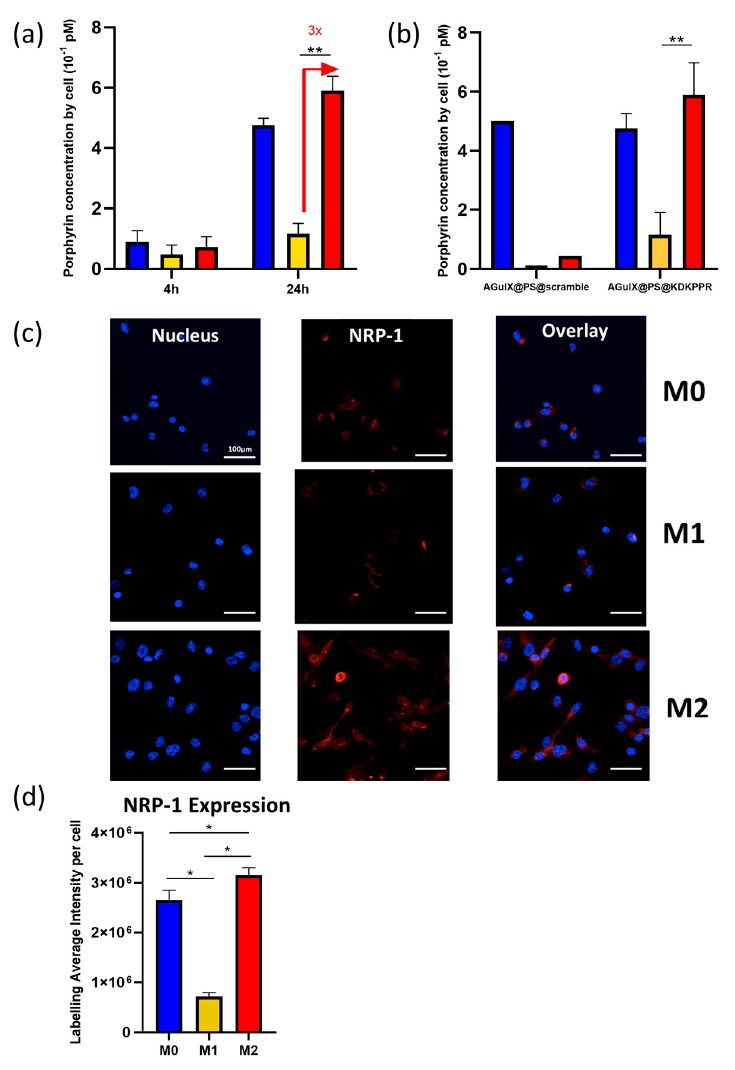
Figure 5. Nanoparticles uptake regarding NRP-1 expression in macrophage populations. Spectrofluorometric measurement of ( a ) AGuIX@PS@KDKPPR uptake (1 µ M) by macrophages (M0, M1, and M2) as a function of time (4 h or 24 h) and ( b ) AGuIX@PS@KDKPPR and AGuIX@PS@scramble 24 h